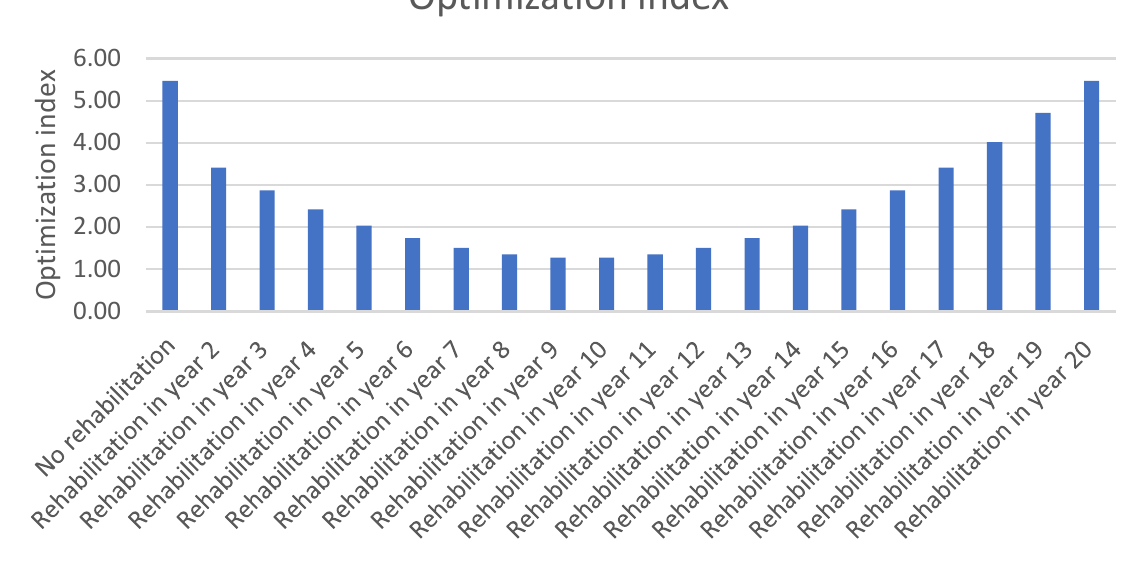
Figure 6. Optimization index calculated following Equation (9).